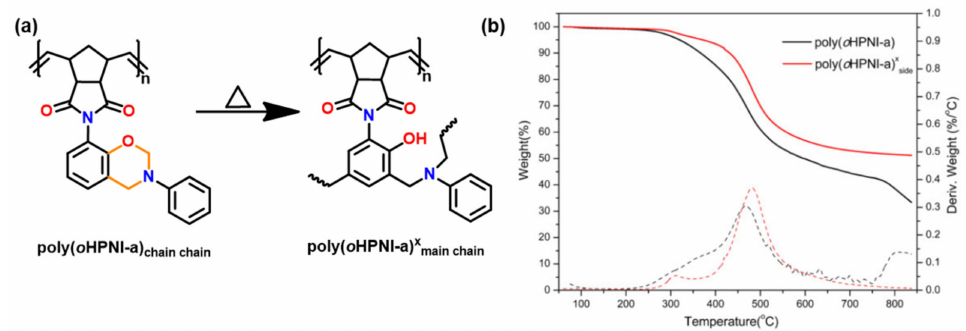
Figure 30. ( a ) Syntheisis of ring-opened main chain polymer; ( b ) thermogravimetric analysis of poly( o HPNI-a) and poly( o HPNI-a) x main chain [245]. Copyright 2019. Reproduced with permission from Sage